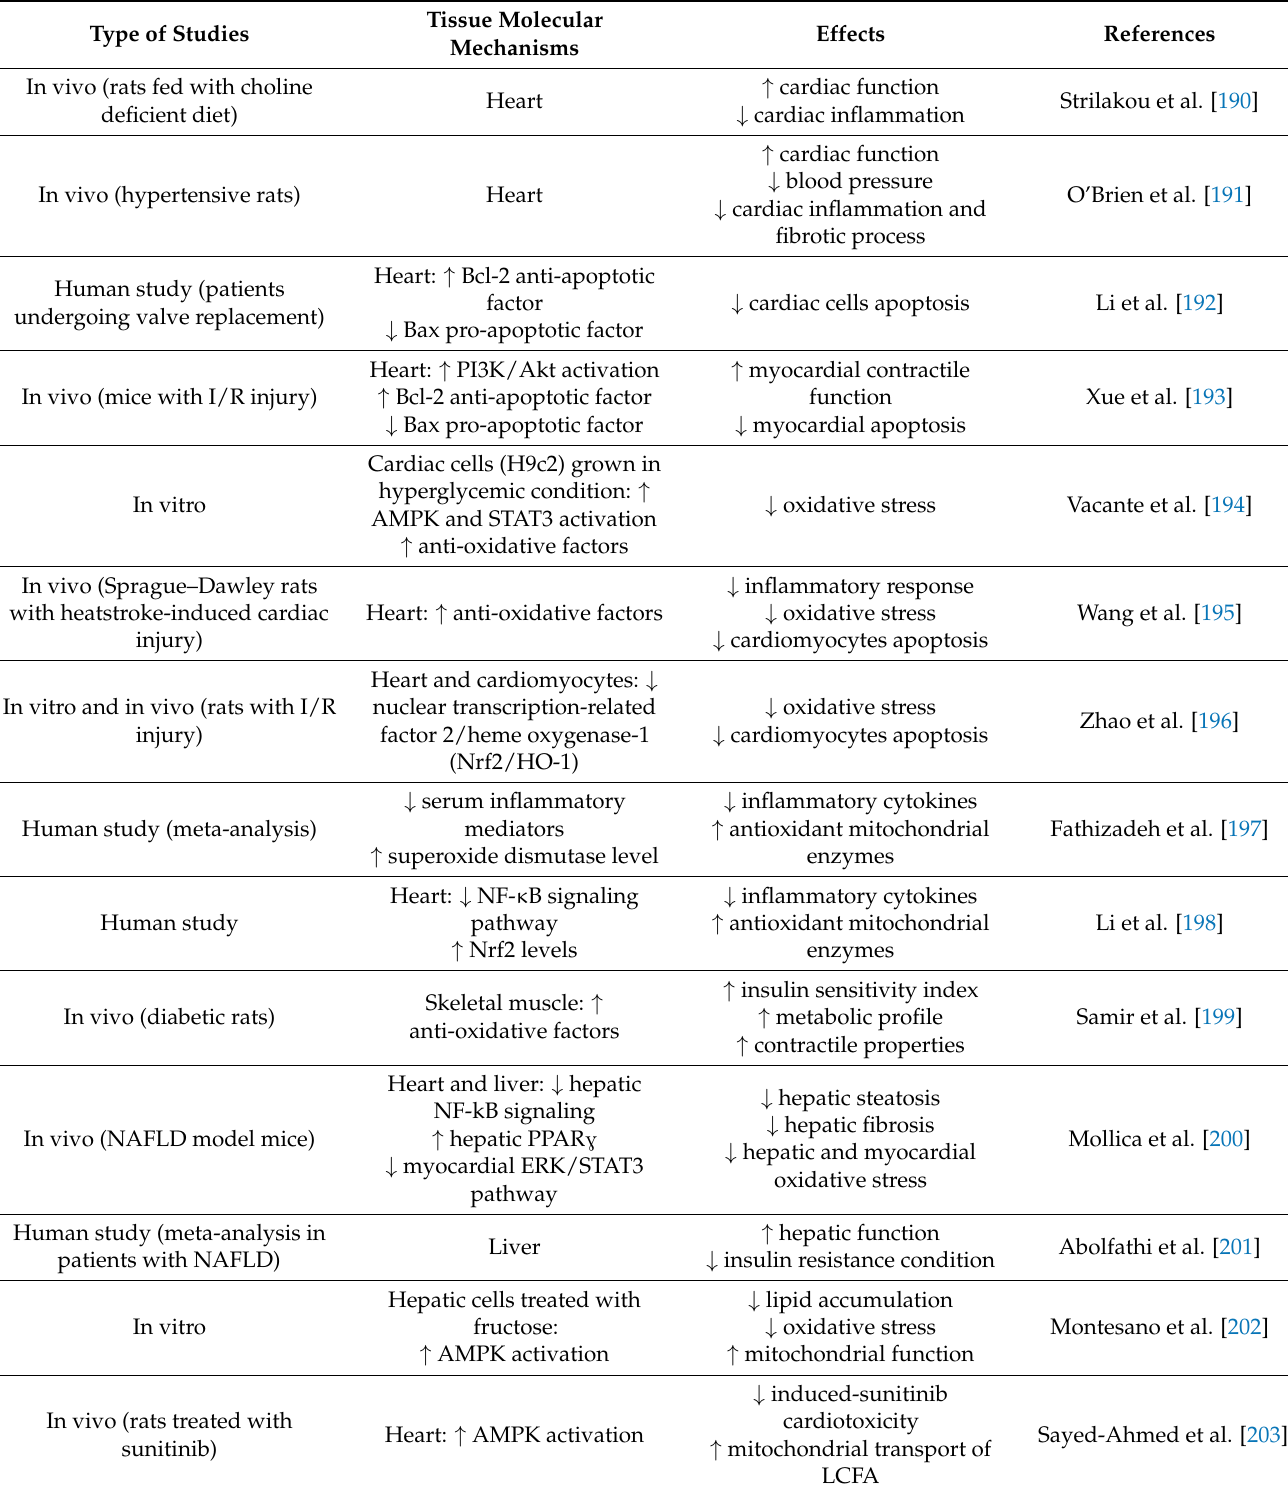
Table 4. L-carnitine as a CR-related nutrient ( ↑ increase/improvement, ↓ decrease/ worsening). Type of